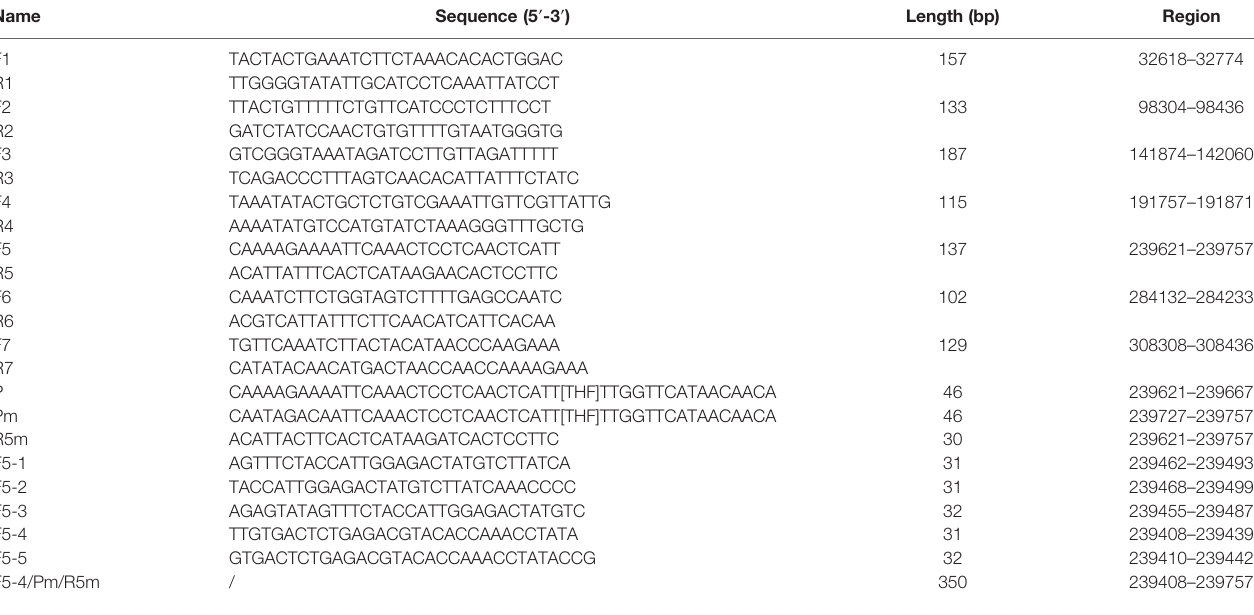
TABLE 1 | Primers and probes for this